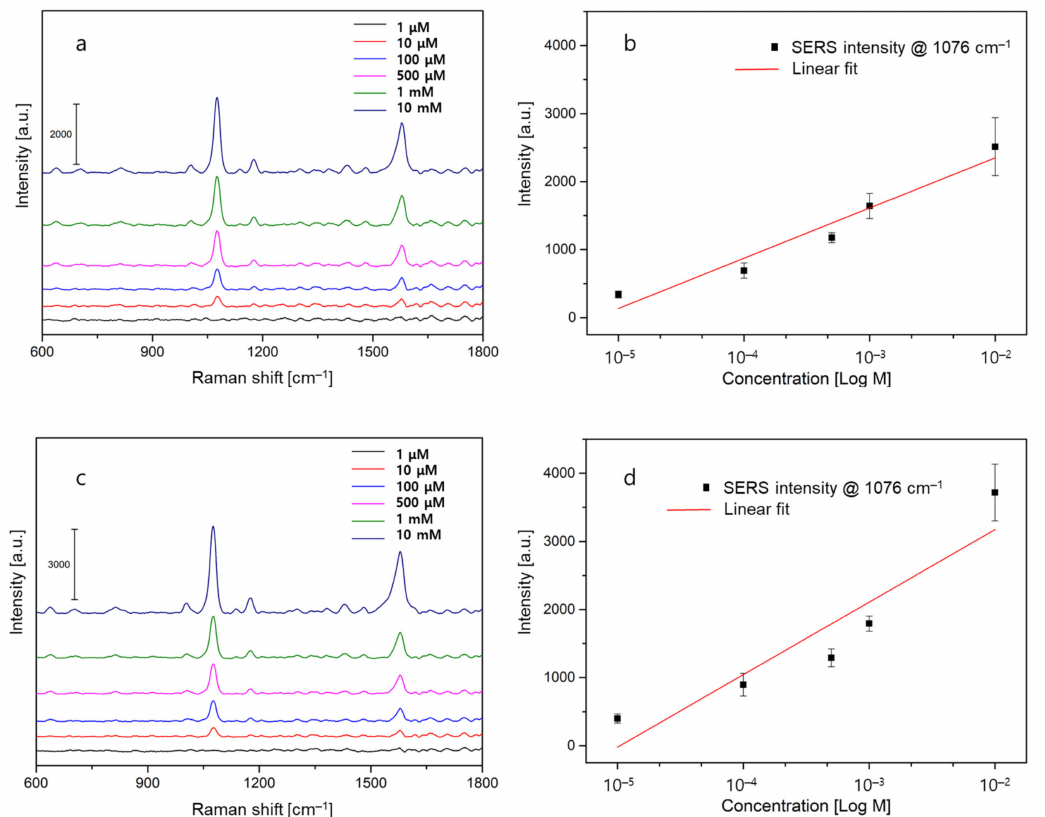
Figure 5. SERS experiments for a varied concentration of 4-ABT molecules. ( a ) SERS measurement data of 4-ABT from 1 µ M to 10 mM and ( b ) Linear regression analysis (the red line) of the intensity at 1076 cm − 1 for silk fiber samples. ( c ) SERS measurement data of 4-ABT and ( d ) Linear regression analysis (the red line) of the intensity at 1076 cm − 1 for multi-mode fiber